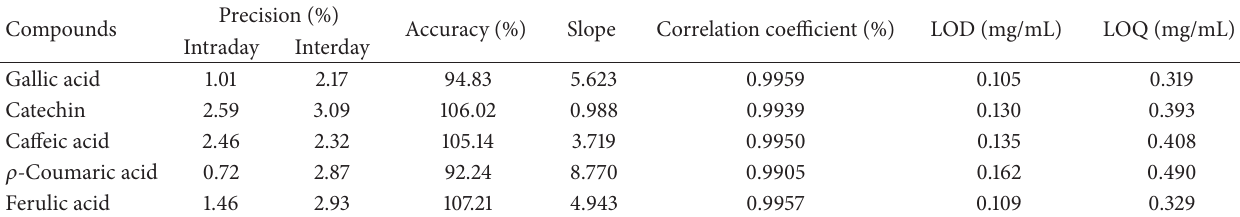
Table 1: Validation parameters of applied HPLC method.